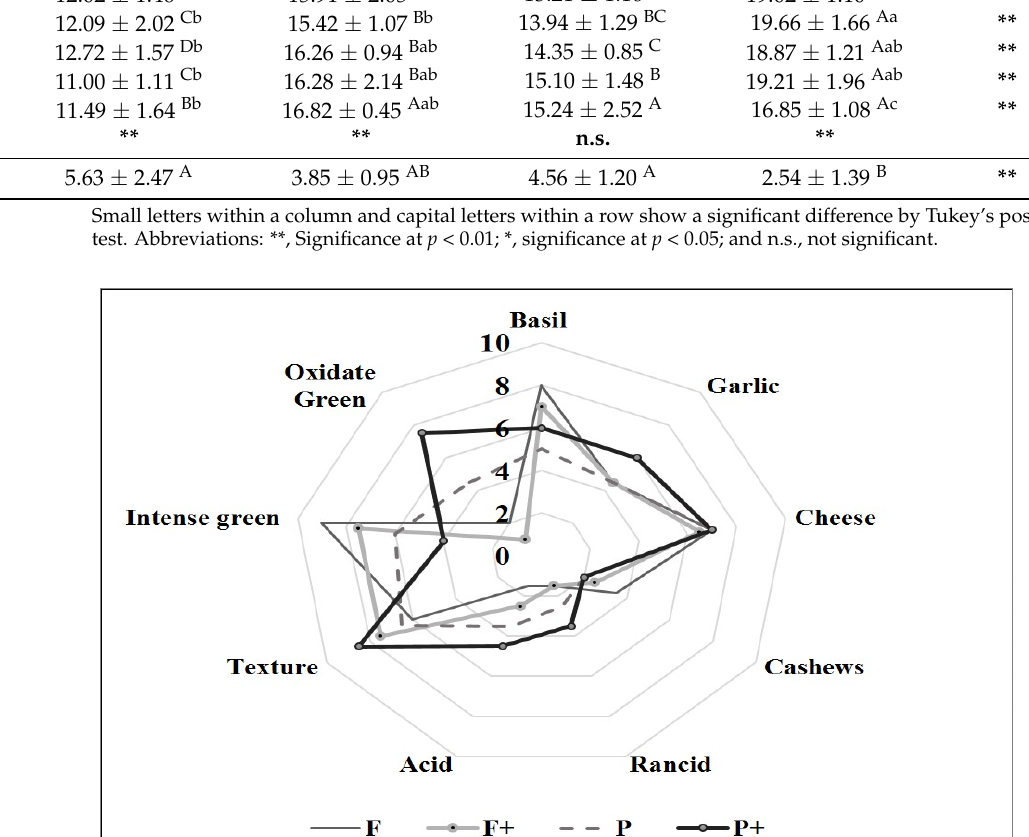
Figure 6. Sensorial evaluation of basil pesto samples during the storage period. The microbiological stability of basil pesto sauce can be affected by different variables such as pH, a w , moisture content, and eventually, the applied thermal treatments. For this reason, it is necessary to prevent the germination of spores by creating a suitable substrate that inhibits spore growth, with a low pH. Acidity regulators are typically added to commercial sauces, however, the addition of these often affects the organoleptic properties of the treated foods. As previously described by Yakhlef et al. [34], the ethyl acetate extraction of OMWW makes it possible to obtain a phenolic extract characterized by a polymeric fraction which exhibits a marked antimicrobial property. In order to inhibit the growth of microorganisms and endogenous enzymes in vegetable ‐ based products, pasteurization heat treatment is industrially used with the aim to stabilize the products [35]. During storage, the enumeration of aerobic mesophilic microorganisms was below the detection limit (<105 CFU.g − 1 ) for pasteurized samples. The combination of thermal treatment and phenolic enrichment enabled inhibition of the growth of yeast and molds